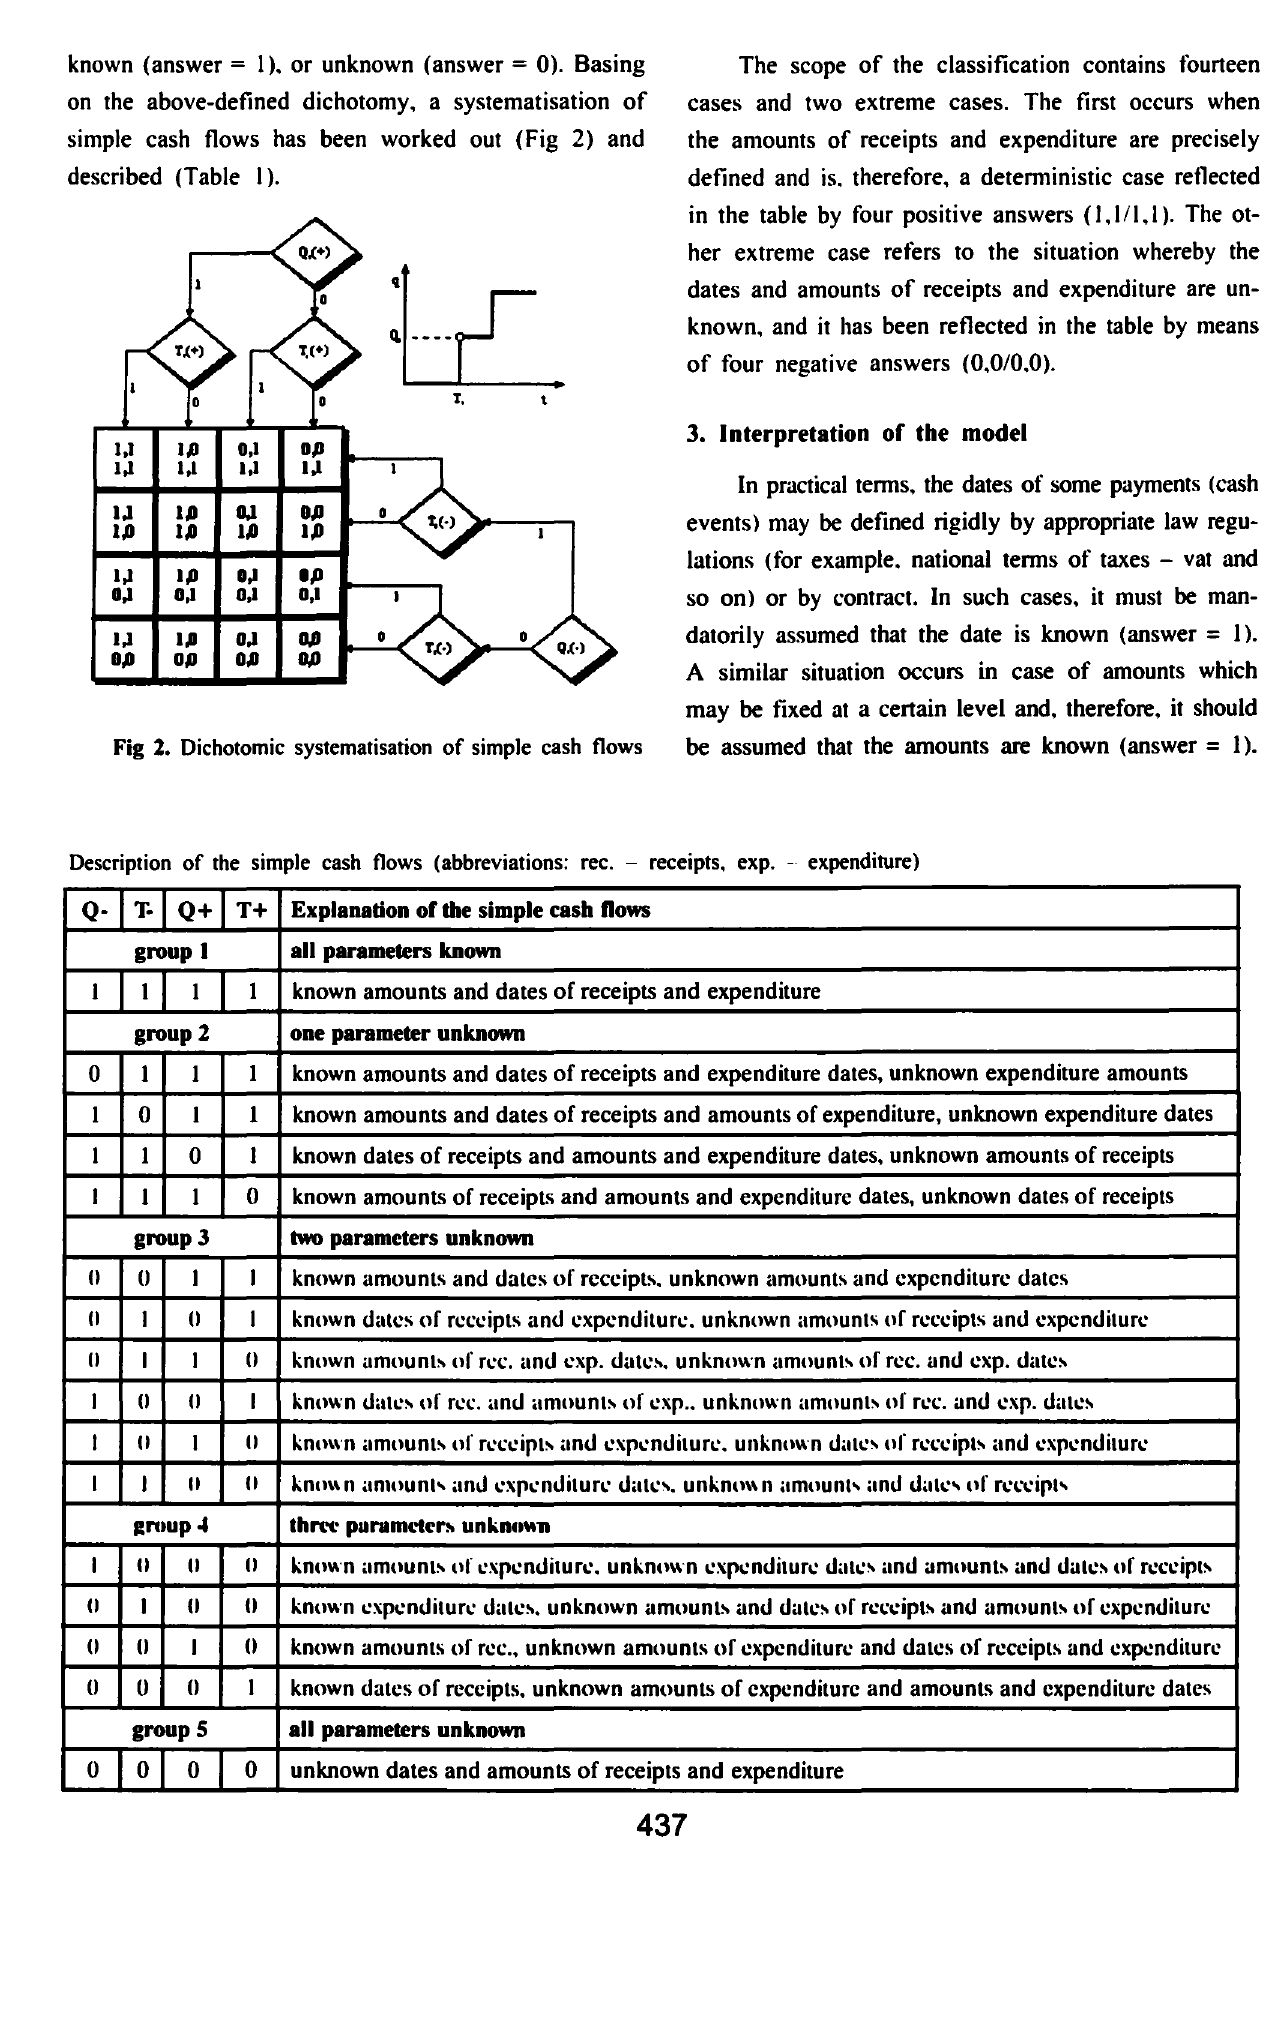
Fig 2. Dichotomic systematisation of simple cash